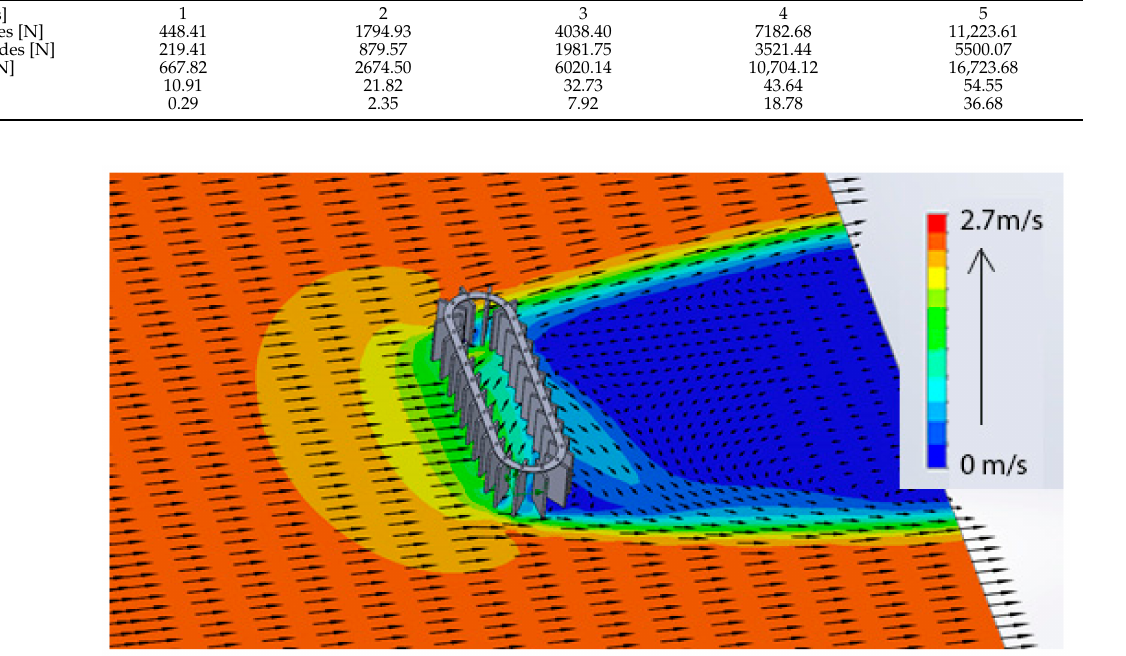
Figure 12. Simulation results at the velocity of 2.7 m/s. The results of the estimated power of the mini-HPP, depending on the velocity of the